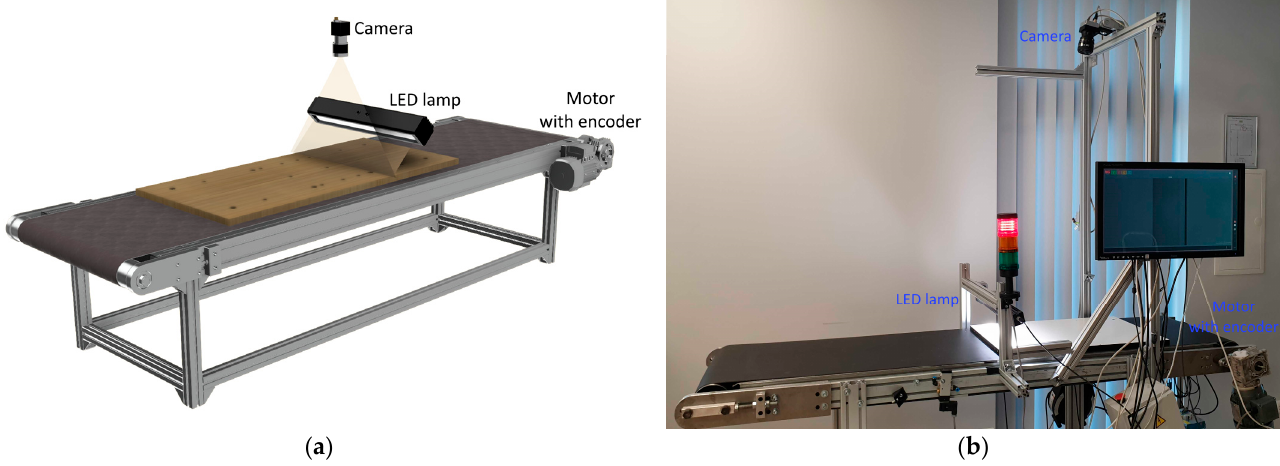
( b ) Figure 6. CoordConv2D representation: ( a ) 2 feature maps along x - and y -axis, indicating the posi- tion of the pixel at each axis; ( b ) CoordConv2D implementation before convolutional operation (adds 2 features maps—y-axis rows and x-axis columns indices). 4. Data 4.1. Image Capture Setup Wooden furniture panels are scanned with a linear camera from an industrial con- veyor. The image data acquisition stand (laboratory) is shown in Figure 7. The main parts of the visual inspection setup are a linear monochromatic camera with a scan width of up to 6144 pixels, an industrial LED light source, and a conveyor. The camera is attached 1.1 m above the conveyor belt. Its capture area (line) collides with an industrial LED light directional normal at the same line. Only the area around the camera scanning line is illu- minated at a particular moment. Furniture panels are moved by a conveyor belt driven by the electrical motor. This motor is equipped with an encoder that triggers a scan of the